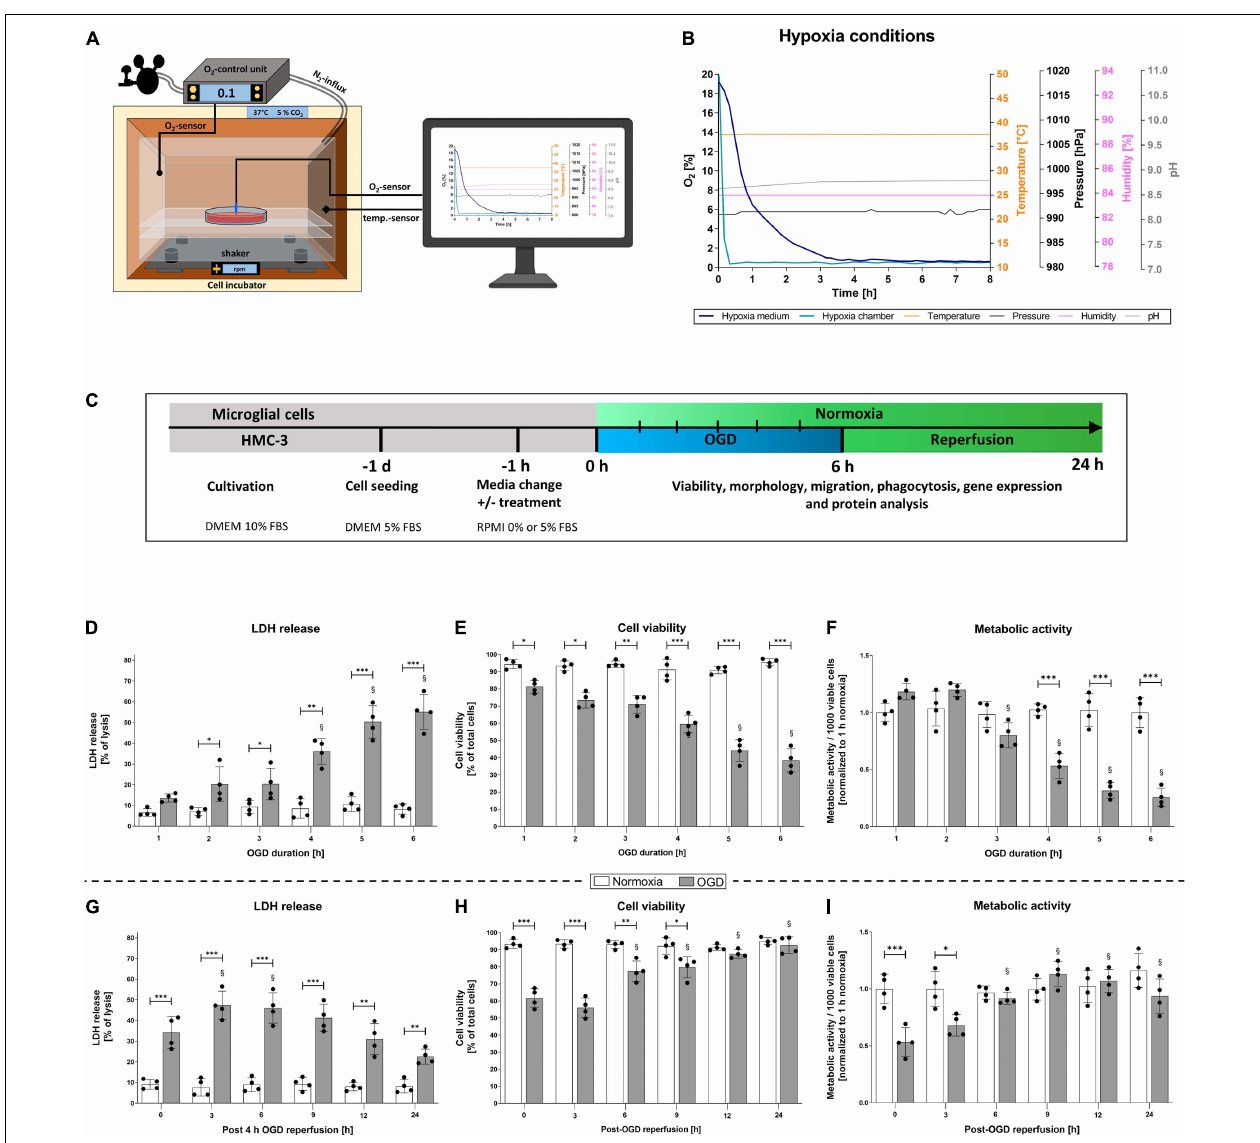
FIGURE 1 | Increasing oxygen-glucose-deprivation (OGD) periods enhance cell death rates and decrease the metabolic activity of human HMC-3 microglial cells. (A) Schematic illustration of customized hypoxia chamber with the ability to monitor and control environmental parameters such as oxygen levels, temperature, pressure, humidity and pH value in the media. (B) Measurement of environmental parameters during HMC-3 OGD experiments ( n = 4 independent experiments). (C) Workflow of OGD and reperfusion (OGD/R) protocol in HMC-3 cells. (D) LDH release, (E) cell count, and (F) metabolic activity after 1–6 h of OGD or the corresponding normoxia control. An OGD duration of 4 h was established for subsequent experiments. (G) LDH release, (H) cell count, and (I) metabolic activity after 4 h of OGD or normoxia followed by up to 24 h of reperfusion. Intergroup differences were tested by ANOVA two-way followed by Tukey post hoc test (multiple comparison). Bars represent means ± SD of 4 individual experiments with 3 technical replicates in each experiment, individual data points are shown. ∗ p < 0.05, ∗∗ p < 0.01, ∗∗∗ p < 0.001 between groups, § p < 0.05 compared to shortest OGD or reperfusion